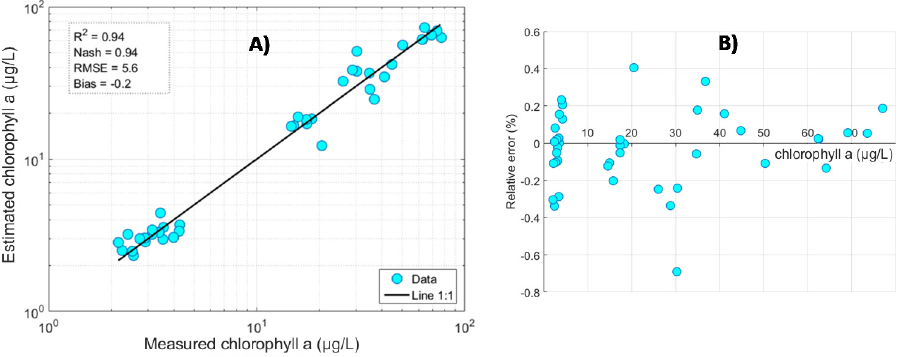
Figure 15. Assessment of the ensemble-based system: ( A ) leave-one-out cross-validation results (presented in a log scale) and ( B ) relative error results.